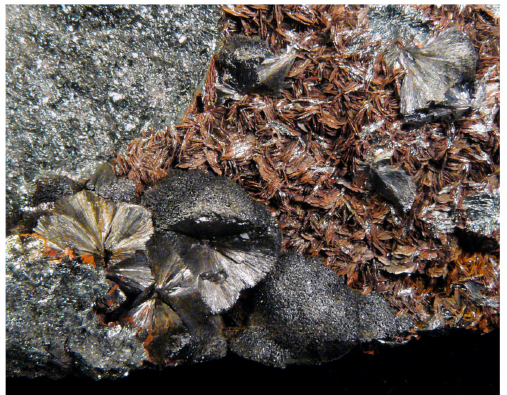
Figure 28. Goethite and hematite, Toothaker Pond prospect. Field of view, 5 cm. Chamberlain Collection, NYSM 35866.